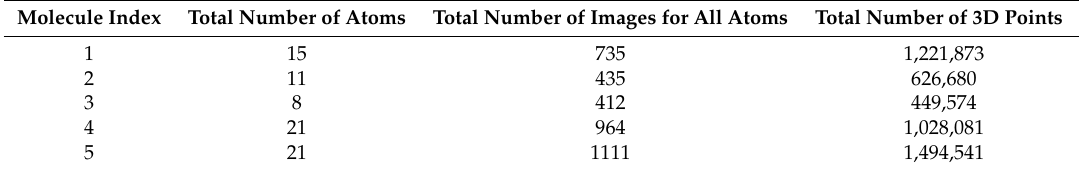
Table 2. Details of the hierarchical atomic model on the Qinling